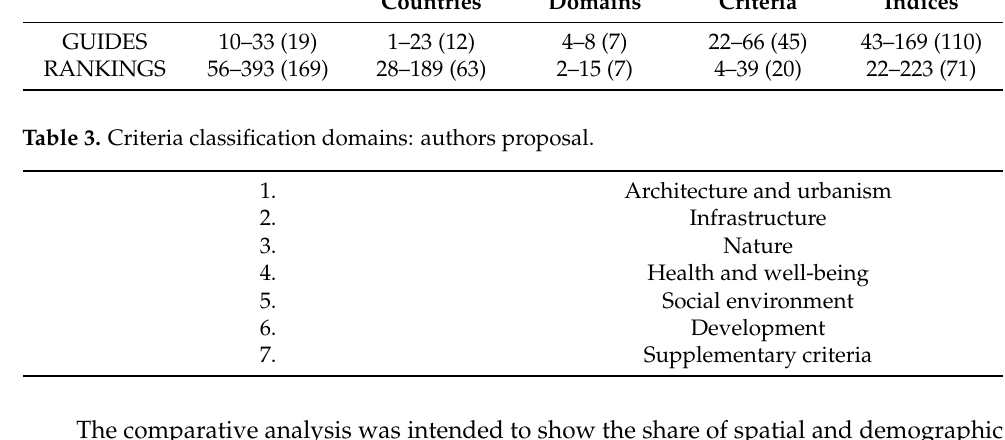
Table 2. Tools. Quantitative data: number of cities, countries, criteria, and indices. Table